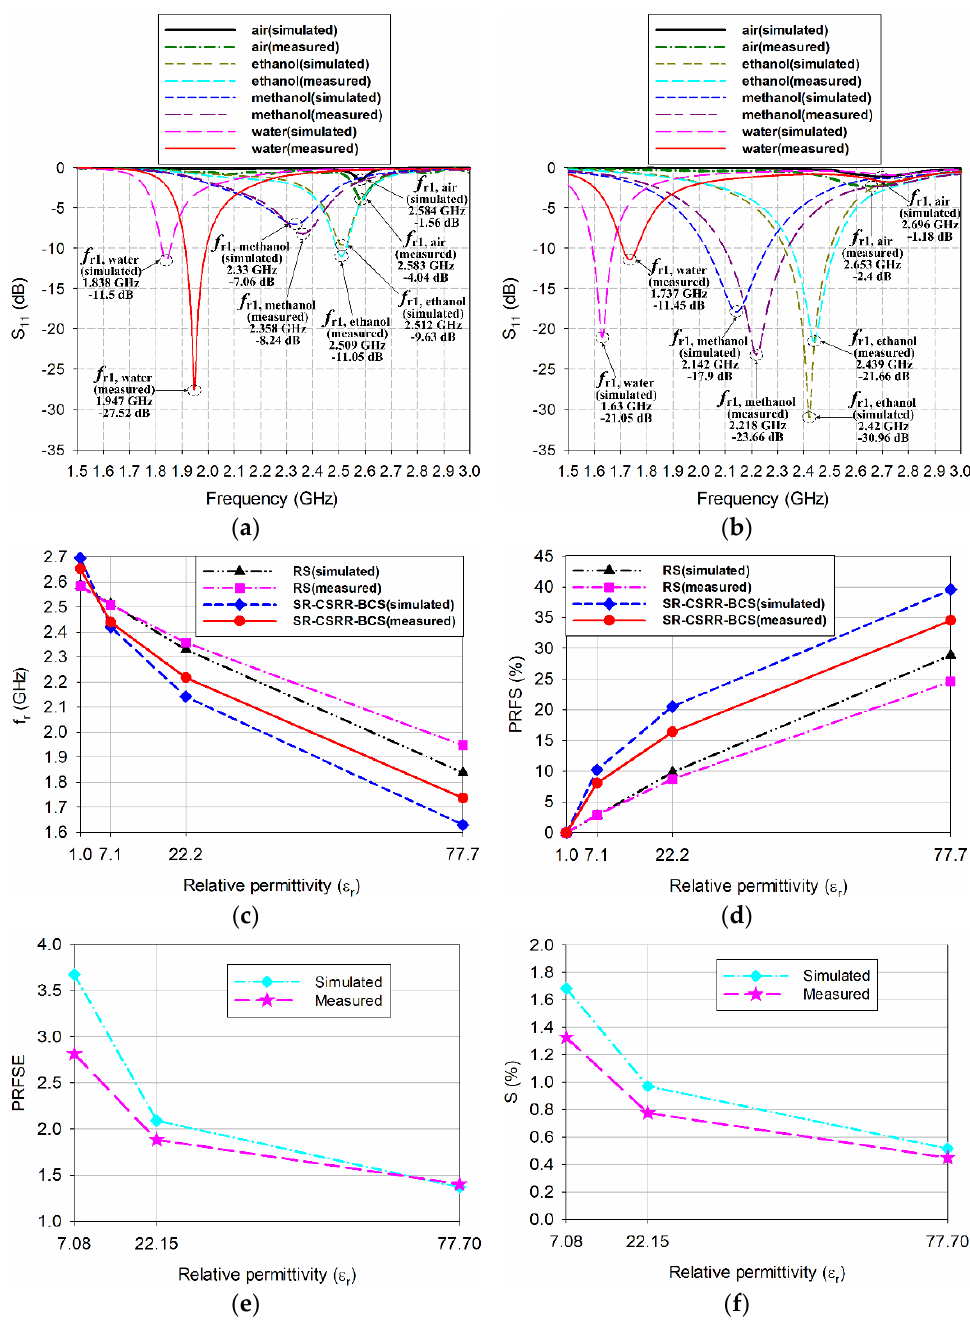
Figure 18. Measured results of the fabricated RS ‐ loaded and SR ‐ CSRR ‐ BCS slot ‐ loaded MPAs: ( a ) input reflection coefficient characteristics of the fabricated RS ‐ loaded MPA, ( b ) input reflection coefficient characteristics of the fabricated SR ‐ CSRR ‐ BCS slot ‐ loaded MPA, ( c ) the values of the first resonant frequency, ( d ) PRFS of the first resonant frequency, ( e ) PRFSE of the first resonant frequency for the SR ‐ CSRR ‐ BCS slot ‐ loaded MPA compared to that of the RS ‐ loaded MPA, and ( f ) sensitivity (%) of the first resonant frequency for the SR ‐ CSRR ‐ BCS slot ‐ loaded MPA.